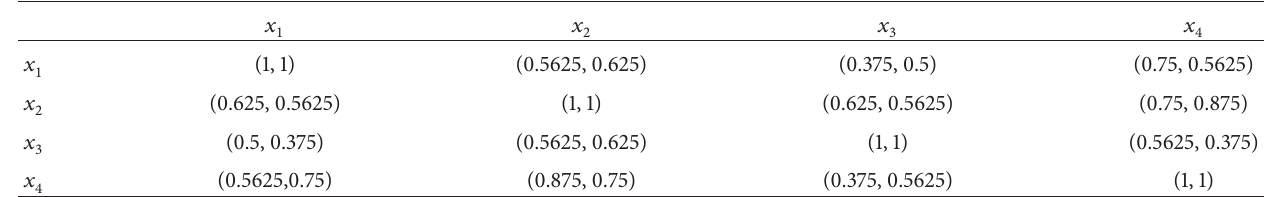
Table 2: Consistency levels of preference values provided by 𝑒 2